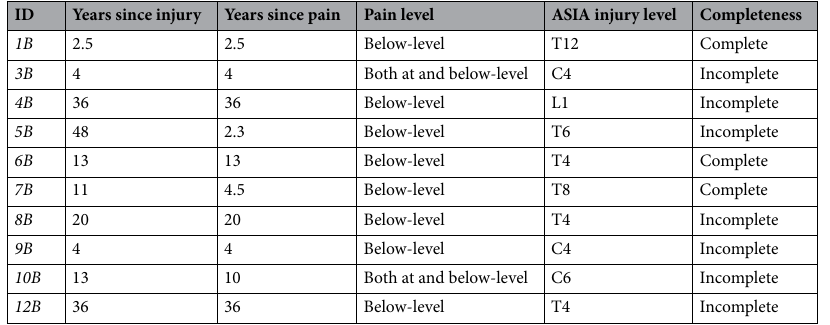
Table 2. CNP participant demographics. CNP central neuropathic pain, “B” denotes CNP participants. Two CNP participants (i.e. 2B and 11B) were removed from the analysis due to excessive noise in the EEG data that prevented EEG